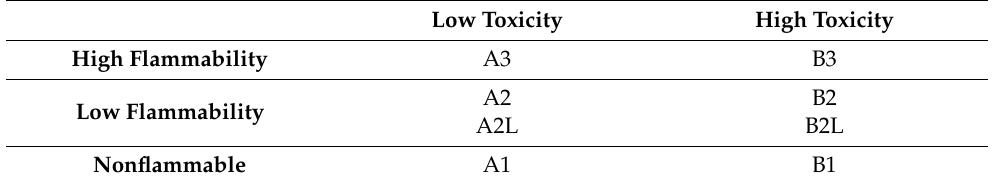
Table 3. Safety Classifications of ASHRAE Standard 34-2019 [3].